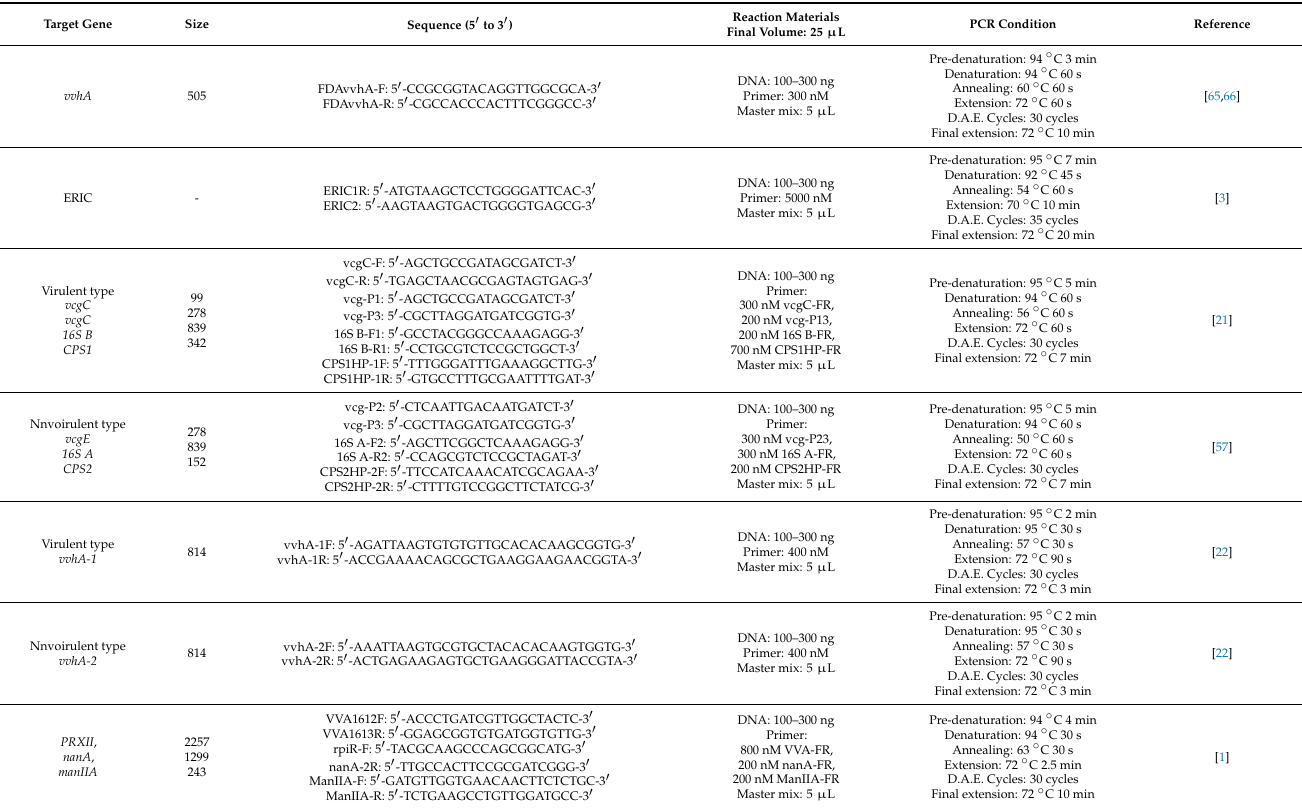
Table 4. PCR primers and conditions for targeting toxin gene profiles, and the identification and differentiation of V. vulnificus